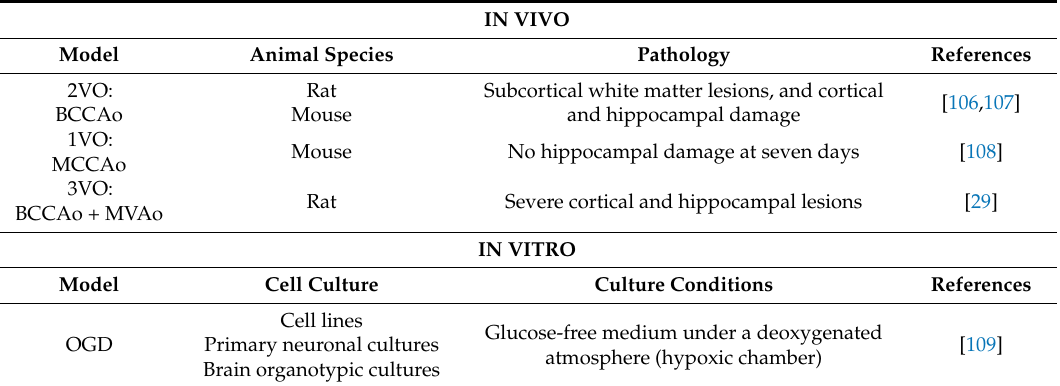
Table 1. Experimental models of brain